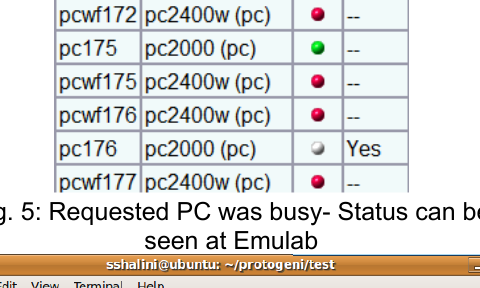
Fig. 5: Requested PC was busy- Status can be seen at Emulab